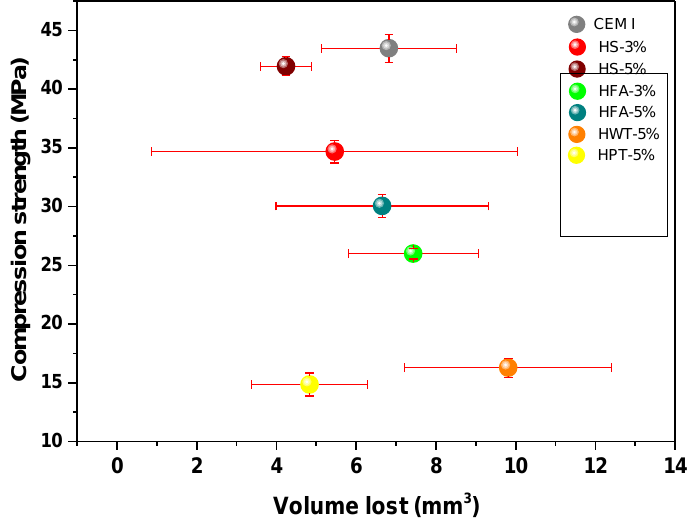
Figure 6. Effect of compression strength of hybrid mortars on the lost volume (mm 3 ) after the Böhme test.